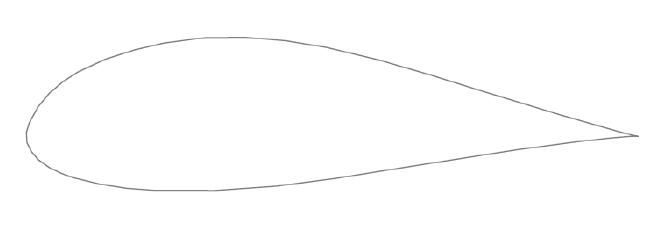
Figure 2. Eppler-387 airfoil.